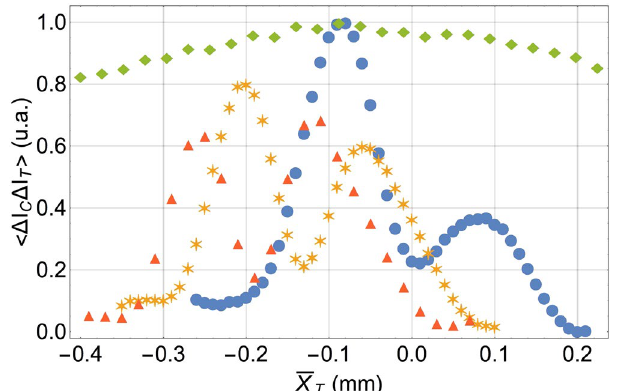
Figure 2. Experimental demonstration of the sensitivity of second-order interference to the transverse position X a remote double-slits ( T ) whit respect to the other ( C ). The experimental results of the correlation measurement ∆ ∆ ⟨ ⟩ I I are obtained by scanning the mask T in the transverse plane, while keeping fixed both the mask C and the C T two detectors D T and D C . The (blue) circles, (yellow) stars and (red) triangles correspond to different positions of the fixed mask C . In particular, the stars and triangles are obtained after displacing mask C by ∆ = . X 0 11mm ∆ = . X 0 17mm , respectively, with respect to its original position (circles). The (green) diamonds represent the C normalized intensity measured by D T while scanning mask T in the transverse plane; no interference effect appears at first order. Error bars are smaller than the point size for both first and second order